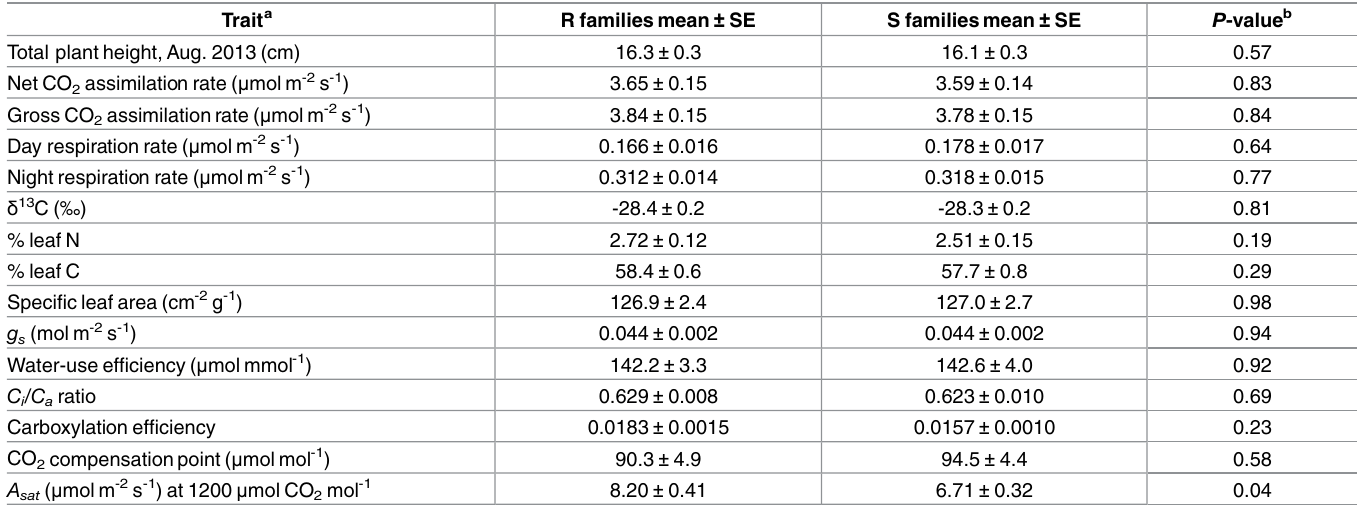
Table 3. Parameters of leaf-levelresource investment and photosyntheticresource-usefor R and S familiesof limberpine. Trait